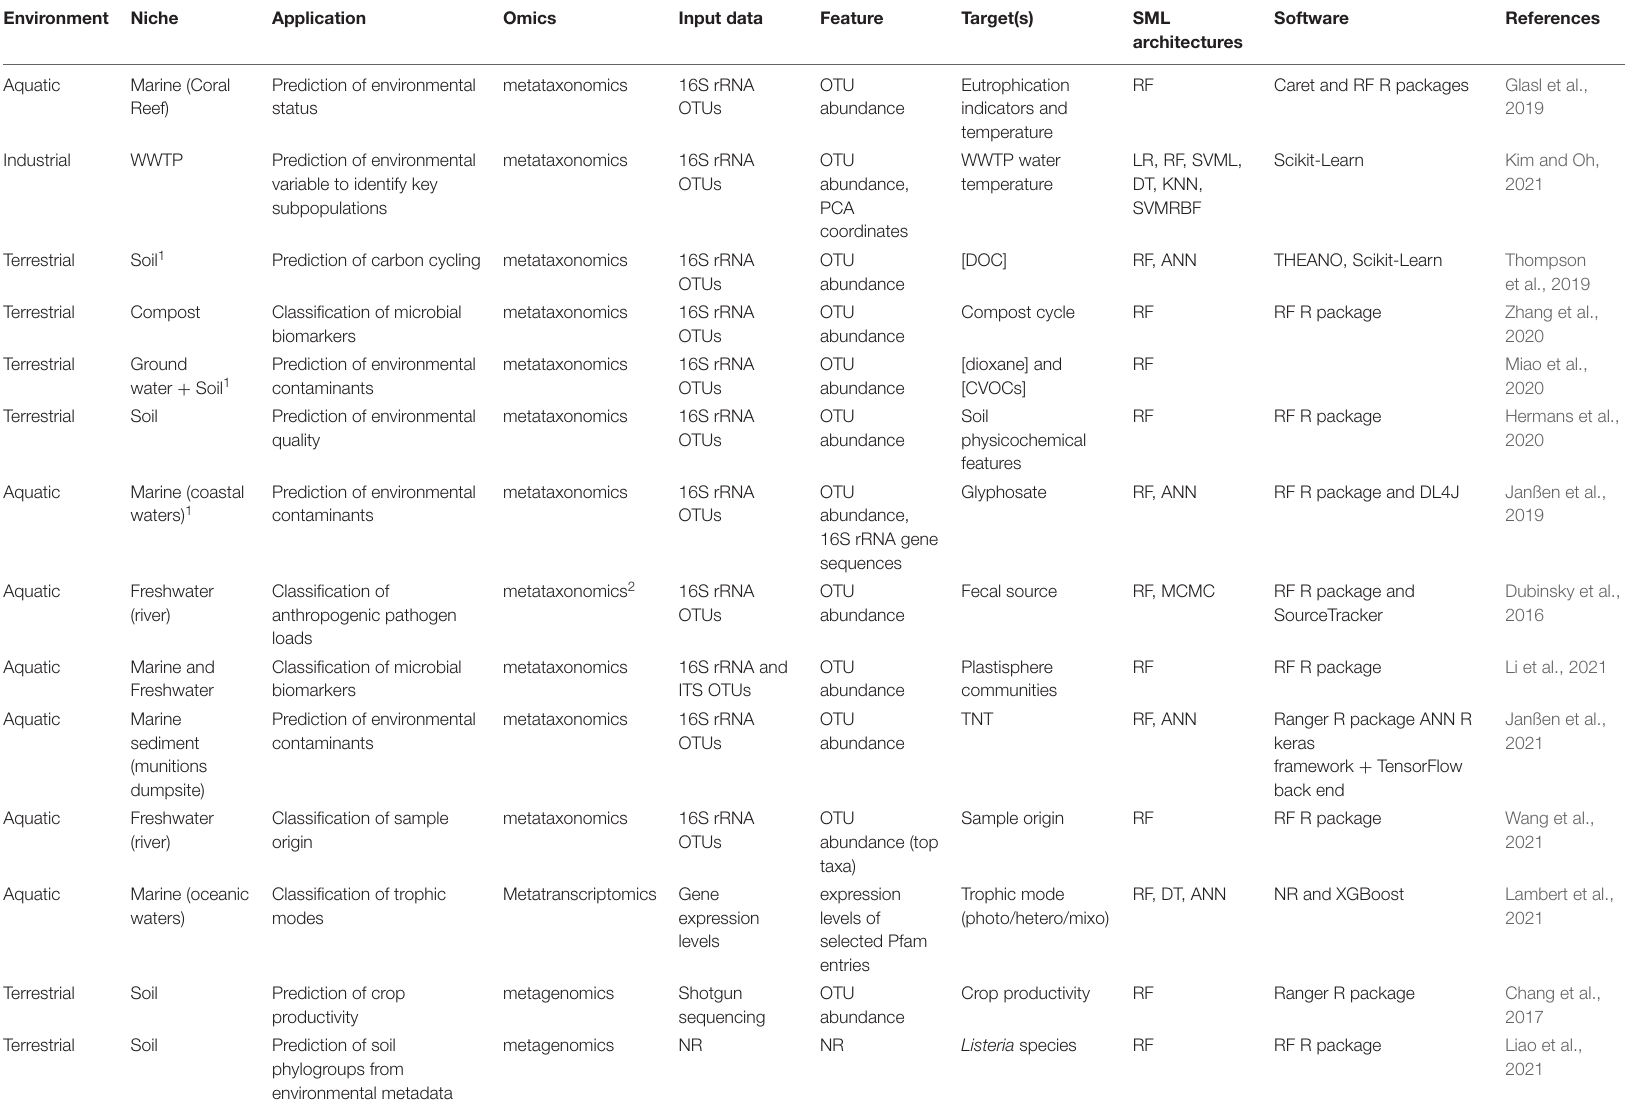
TABLE 1 | Example applications of the SML of microbial Omics data for addressing environmental challenges. Environment